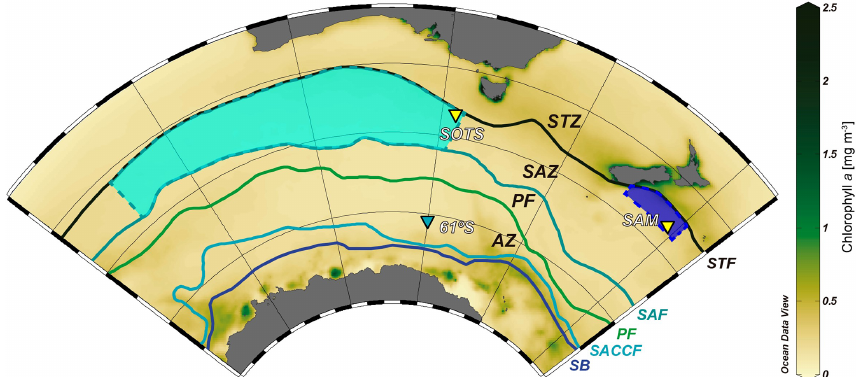
Figure 1. Chlorophyll a composite map of the Australian–New Zealand sector of the Southern Ocean (July 2002 to July 2012) from the MODIS Aqua sensor showing the location of the sediment trap moorings sites: SOTS, 61 ◦ S and SAM. The regions for which the SOTS and SAM sites are representative are marked with light- and dark-blue areas, respectively. Abbreviations: subtropical zone – STZ, subtropical front – STF, subantarctic zone – SAZ, subantarctic front – SAF, polar frontal zone – PFZ, polar front – PF, Antarctic zone – AZ, southern Antarctic Circumpolar Current front – SACCF, and southern boundary of the ACC – SB. Oceanic fronts follow Orsi et al. (1995). Ocean Data View software (Schlitzer, 2018) was used to generate this